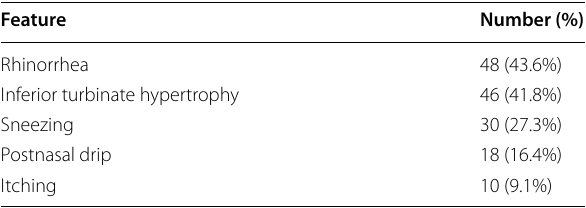
Table 2 The socio‑clinical characteristics of the pregnant women with (110) and without (834)